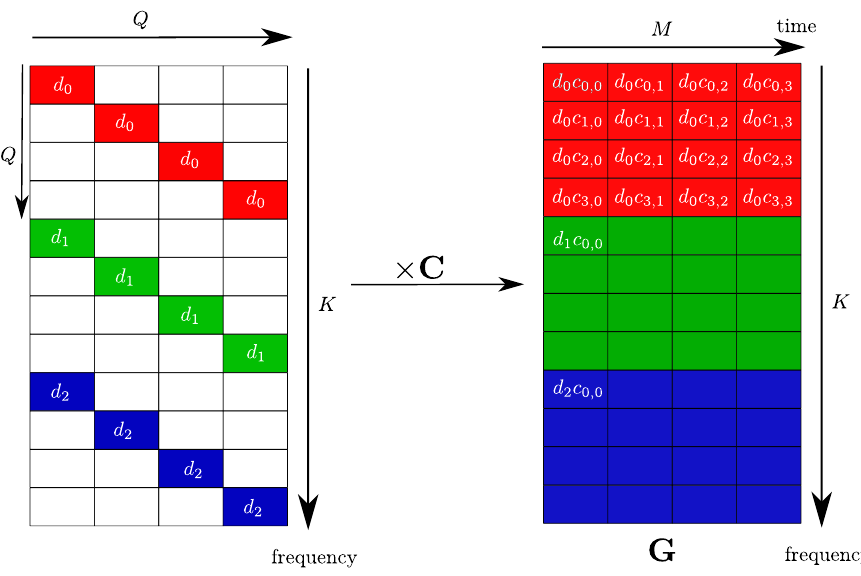
Figure 4. Example: spreading in MC-SS-2D.